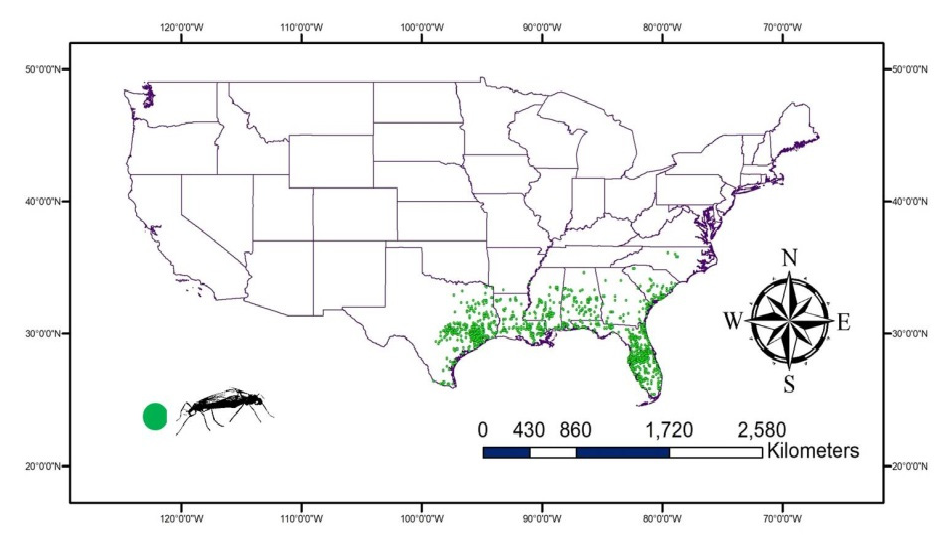
Figure 1. The occurrence of Plecia nearctica recorded Global Biodiversity Information Facility (GBIF) reveal the distribution of lovebugs in the Southern USA. Table 1. Environmental variables used in the study.